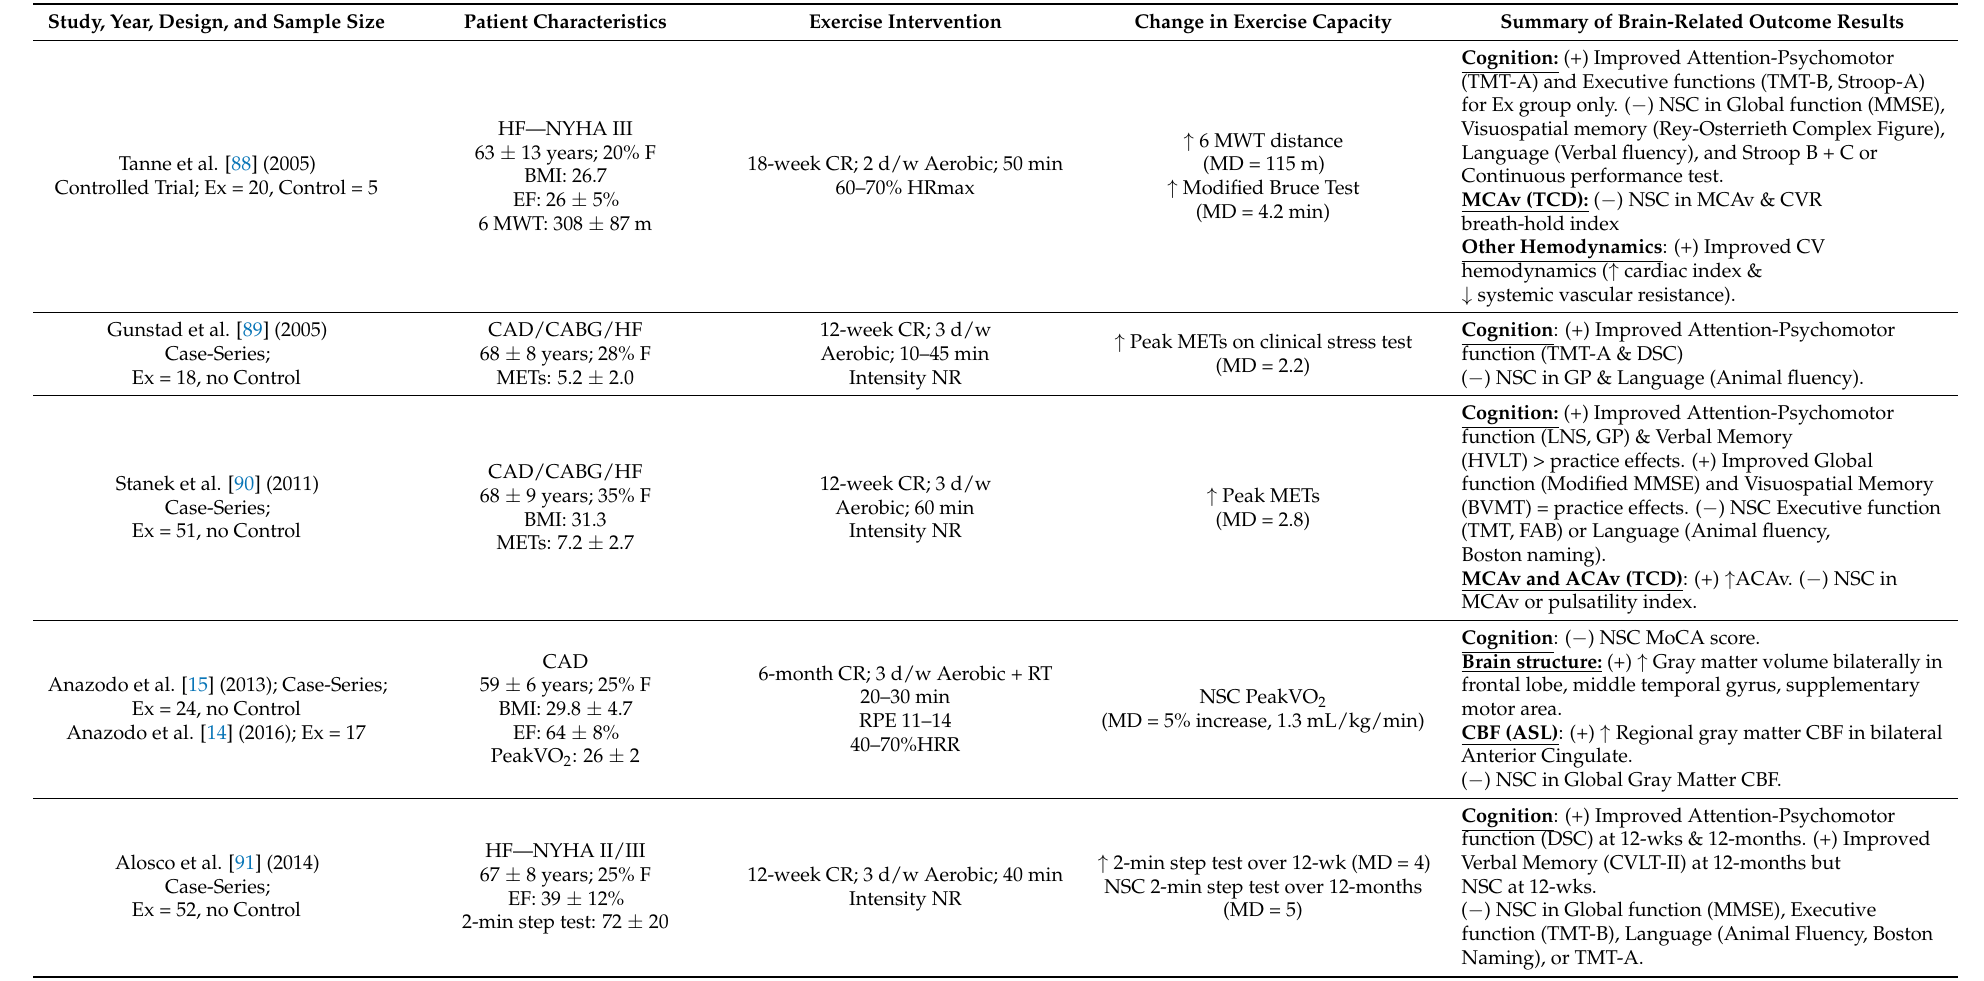
Table 1. Chronic Exercise Training Studies in Patients with CVD Assessing Change in Brain-related Outcomes. Study, Year, Design, and Sample